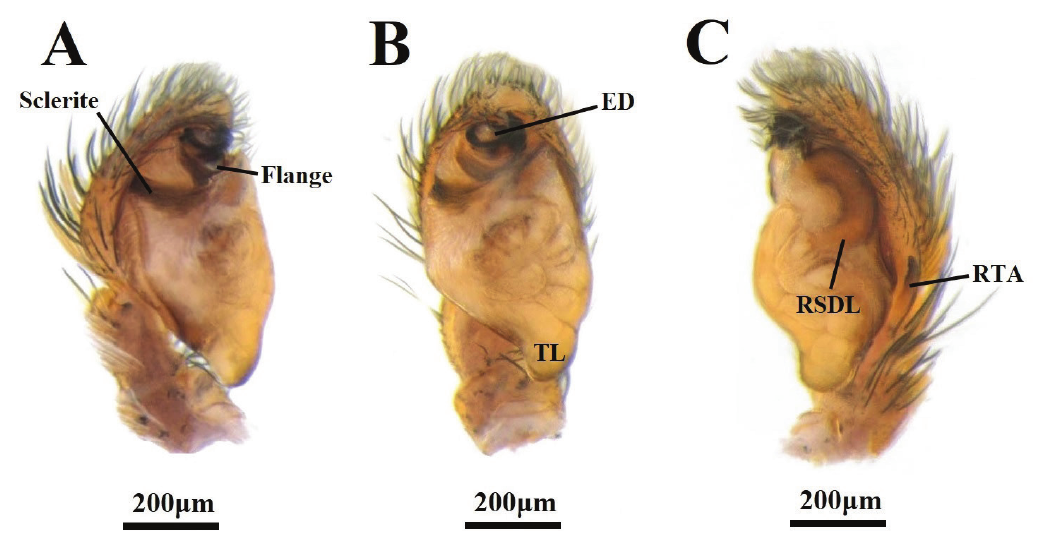
Figure 3. Preserved holotype Maratus nemo sp. nov. (SAM NN30706): left pedipalp structure A prolateral view showing dark lateral sclerite proximal to the embolus and distinct thick extension or flange along the proximal arc of embolus B ventral view showing embolic disc and tegular lobe C retrolateral view showing finger-like retrolateral tibial apophysis and retrolateral sperm duct loop. Scale bars